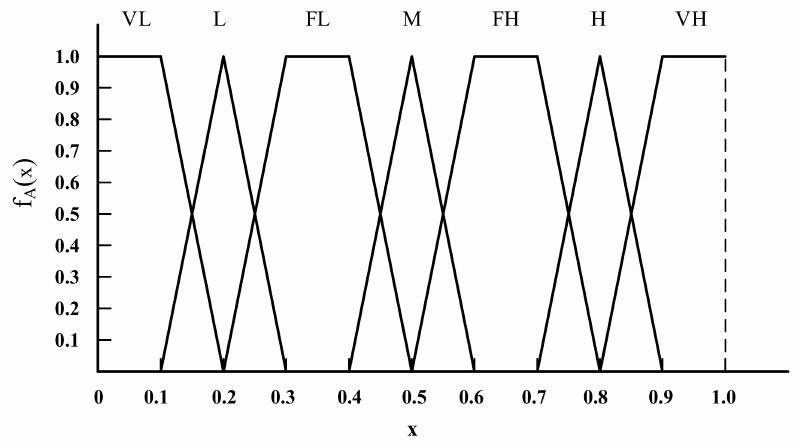
Figure 5. Diagram of fuzzy membership functions. Very Low (VL), Low (L), Fairly Low (FL), Medium (M), Fairly High (FH), High (H) and Very High